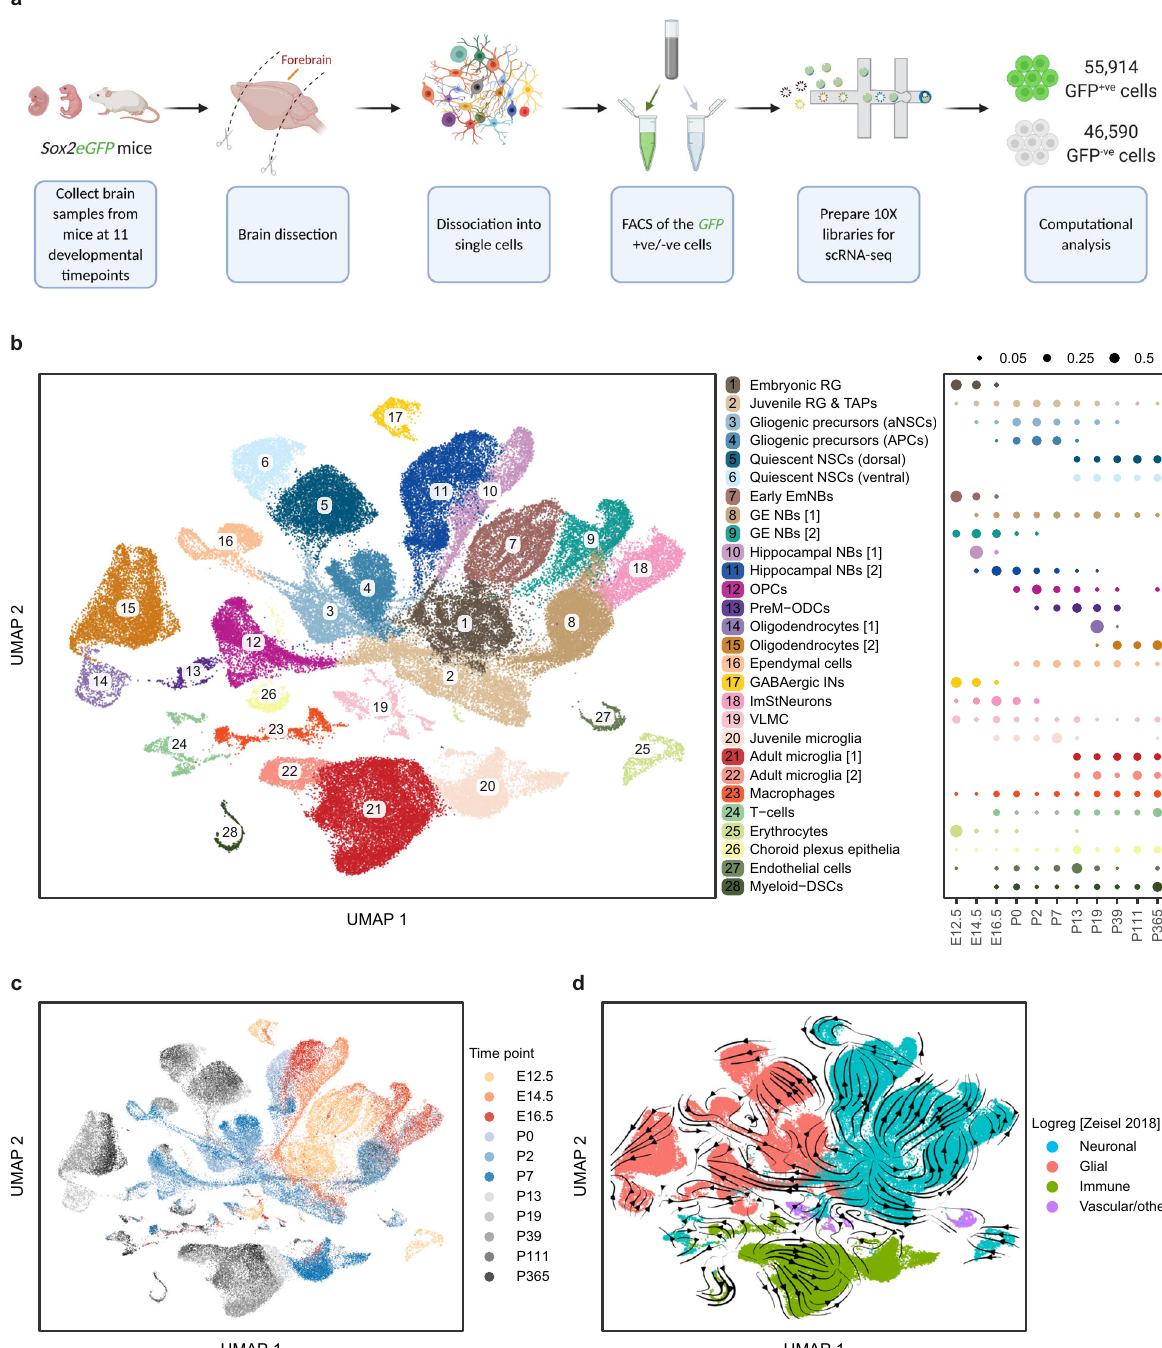
Fig. 1 A comprehensive single-cell atlas of precursor cells across cortical development. a Schematic overview of the experimental work fl ow. Forebrain samples were collected from Sox2eGFP mice at 11 developmental timepoints, dissociated into single cells followed by sorting of the GFP + ve / − ve cells and performing single-cell RNA-seq using the 10x Genomics Chromium platform. b Left: two-dimensional Uniform manifold approximation and progression (UMAP) plot with Leiden clustering of 102,504 individual cells identifying 28 transcriptionally and biologically distinct cell types (see Supplementary Fig. 3a and Methods). Each dot represents a single cell and colours correspond to the distinct clusters/cell types. Shown on the right is a dot plot showing the relative fraction (dot size) of the 28 cell types at each developmental timepoint normalized by library size. c UMAP plot of the cells as in ( b ) but coloured by timepoint. Each dot represents a single cell and the colours correspond to the different timepoints. d , UMAP plot showing the coarse annotation of cells into 4 categories (Neuronal, Glial, Immune and Vascular/other) based on logistic regression from Zeisel et al. 2018. The RNA-velocity fi eld is overlaid on the UMAP. Colours represent the 4 categories of cell annotation and the arrows correspond to the direction of the RNA-velocity fl ow fi eld (see Methods). RG Radial glia, TAPs Transient amplifying progenitors, aNSCs Active neural stem cells, APCs Astrocyte progenitor cells, EmNBs Embryonic neuroblasts, GE NBs Ganglionic eminence neuroblasts, OPCs Oligoprogenitor cells, PreM-ODCs Immature pre-myelinating oligodendrocytes, INs Interneurons, ImStNeurons Immature striatal neurons, VLMC Vascular leptomeningeal cells, Myeloid-DSCs Myeloid-derived suppressor